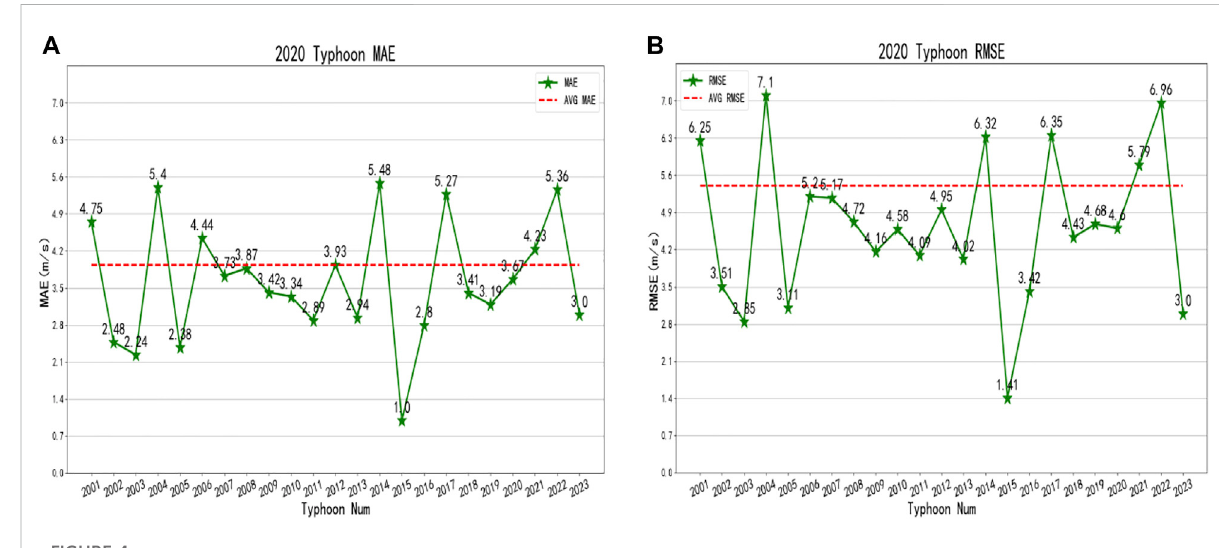
FIGURE 4 MAE (A) and RMSE (B) of the ResNet model for smart intensity determination of typhoons for the annual sample intensity estimation in 2020.